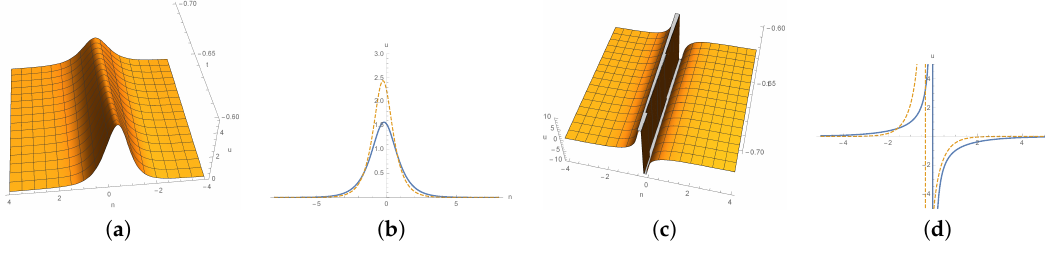
Figure 4. u n given by (35) for c 1 = 1 and α 1 = 1. ( a ) shape and motion with (cid:101) = − 1; ( b ) waves in blue (solid line) and yellow (dotted line) stand for plot ( a ) at t = − 0.8 and t = − 0.7, respectively; ( c ) shape and motion with (cid:101) = 1; ( d ) waves in blue (solid line) and yellow (dotted line) stand for plot ( c ) at t = − 1 and t = − 0.6, respectively.